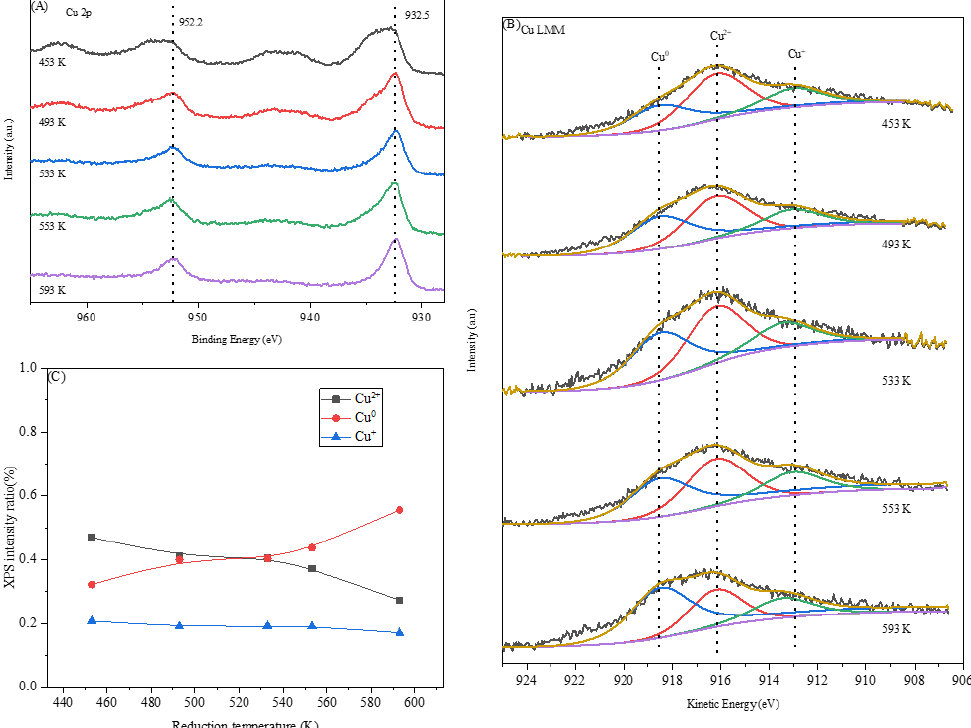
Figure 6. Samples of CMA-L after reduction at 453–593 K: XPS spectra of Cu 2p ( A ), corresponding spectra of Cu LMM ( B ), and ratios of copper species ( C ). Table 4. Cu LMM results of CMA-L catalysts after reduction.